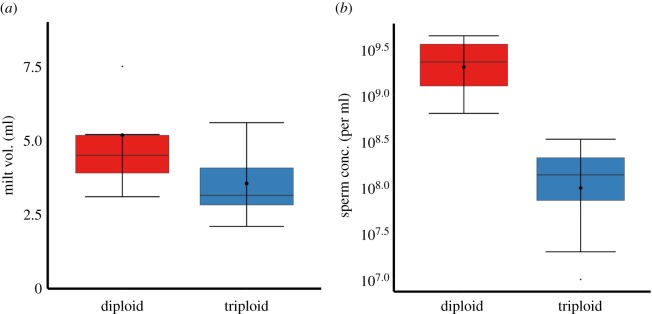
Milt volume (ml) and sperm concentration (per ml of milt) from male diploid (n = 10) and triploid (n = 10) 3-year-old Atlantic salmon. Boxplots show median (horizontal black line) and mean (thick black dot); whiskers indicate points within the 1.5 IQR and quartile ranges (coloured box area).